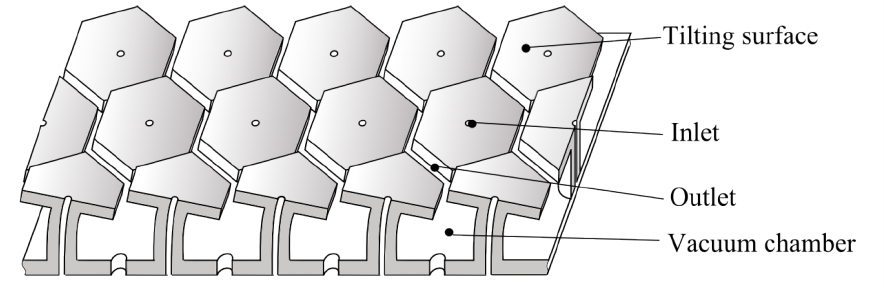
Figure 2. The tilting surface concept, the surfaces are titled by bending the shafts [4].